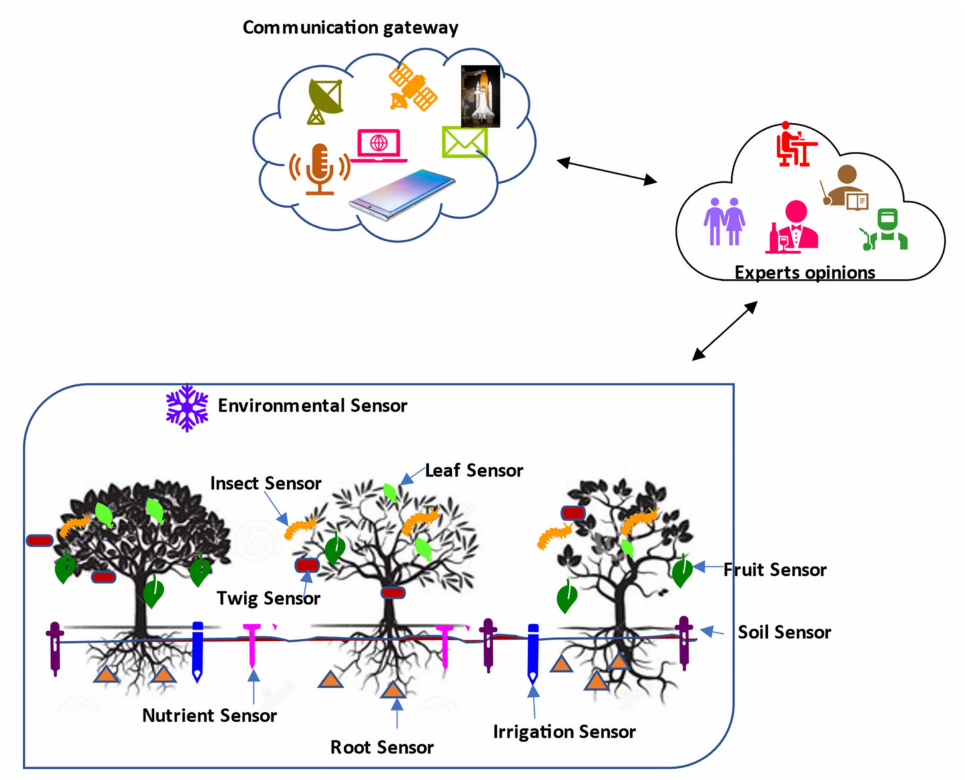
Figure 6. An Internet-of-Things-based network for smart